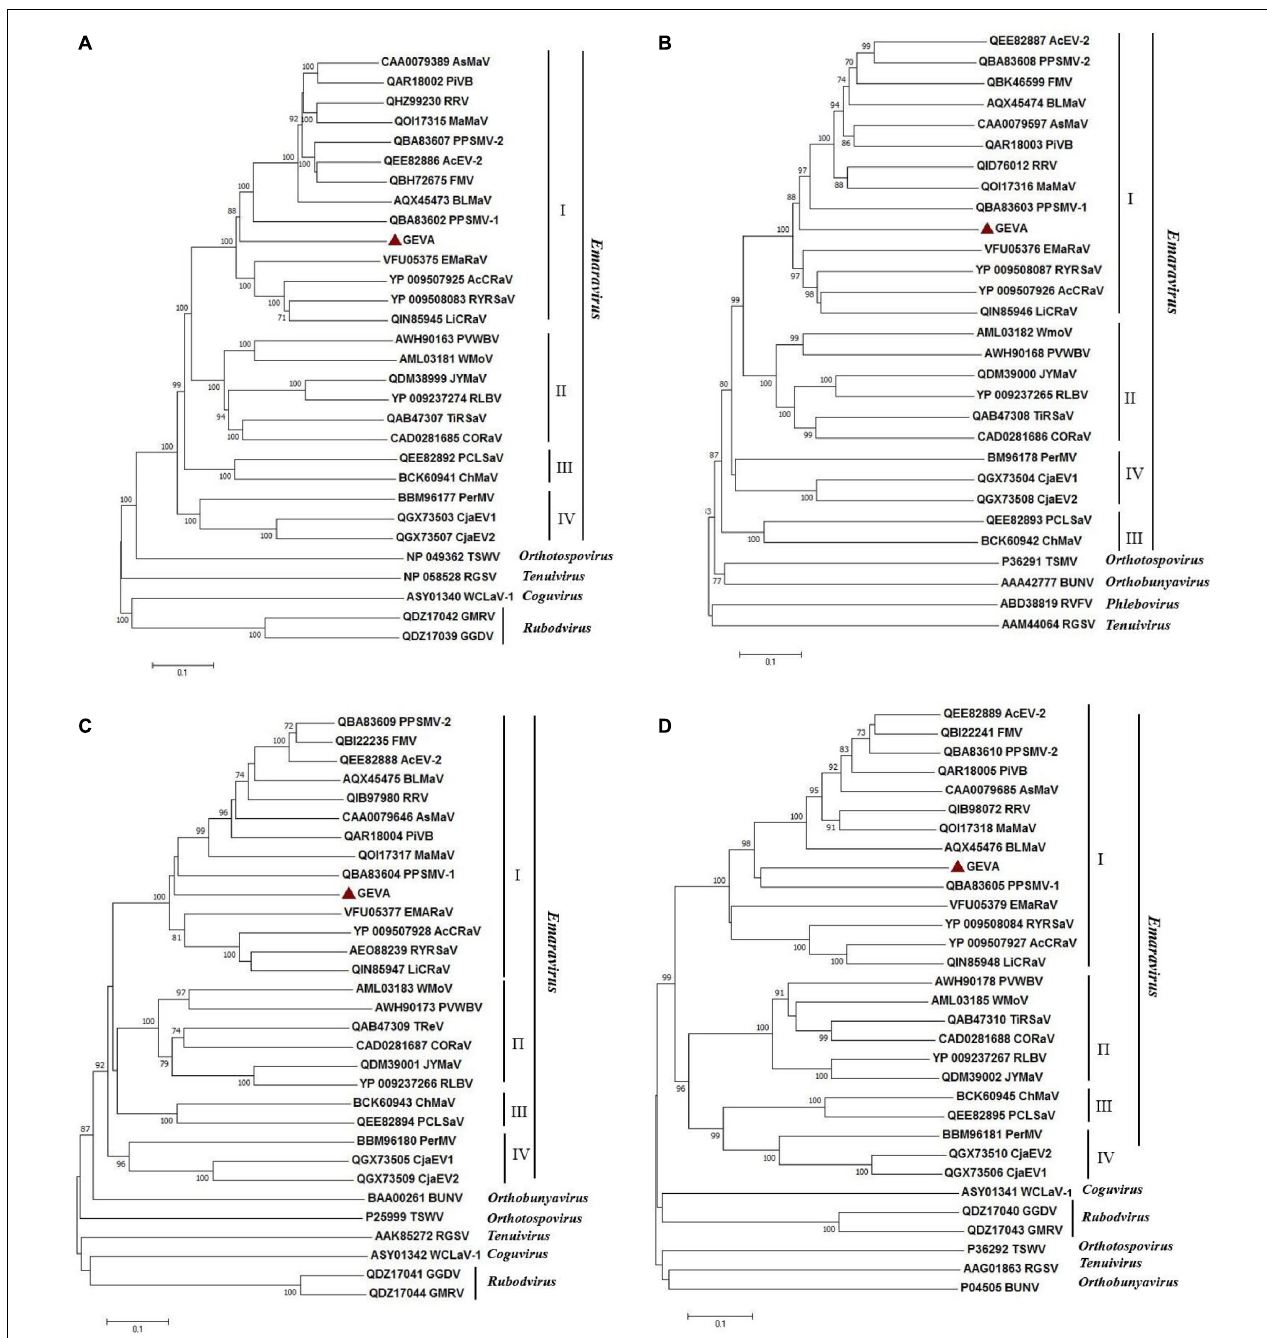
FIGURE 4 | Unrooted neighbor-joining (NJ) phylogenetic trees generated from the deduced amino-acid sequences of the RNA-dependent RNA polymerase (P1) (A) , glycoprotein precursor (P2) (B) , nucleocapsid protein (P3) (C) , and movement protein (P4) (D) of emaraviruses. Orthologs from representative members of the genera Orthotospovirus , Orthobunyavirus , Coguvirus , Tenuivirus , Rubodvirus , and Phlebovirus are included in these trees. The bar represents the number of amino-acid replacements per site. GenBank accession numbers of proteins used for phylogenetic analyses are reported. Grapevine emaravirus A (GEVA) is highlighted by a red triangle. FMV, fig mosaic virus; PPSMV-1, pigeonpea sterility mosaic virus 1; PPSMV-2, pigeonpea sterility mosaic virus 2; PiVB, Pistacia virus B; RRV, rose rosette virus; BLMaV, blackberry leaf mottle-associated virus; EMARaV, European mountain ash ringspot-associated virus; AcCRaV, Actinidia chlorotic ringspot-associated virus; RYRSaV, redbud yellow ringspot-associated virus; RLBV, raspberry leaf blotch virus; PVWBV, palo verde witches broom virus; WMoV, wheat mosaic virus; AcEV-2, Actinidia emaravirus 2; JYMaV, jujube yellow mottle associated virus; TiRSaV, ti ringspot-associated virus; AsMaV, aspen mosaic-associated virus; LiCRaV, lilac chlorotic ringspot-associated virus; PerMV, Perilla mosaic virus; PCLSaV, pear chlorotic leaf spot-associated virus. TSWV, tomato spotted wilt virus; BUNV, bunyamwera virus; WCLaV-1, watermelon crinkle leaf-associated virus 1; RGSV, rice grassy stunt virus; GMRV: Muscat rose virus; GGDV, grapevine Garan dmak virus; RVFV, Rift Valley fever virus.